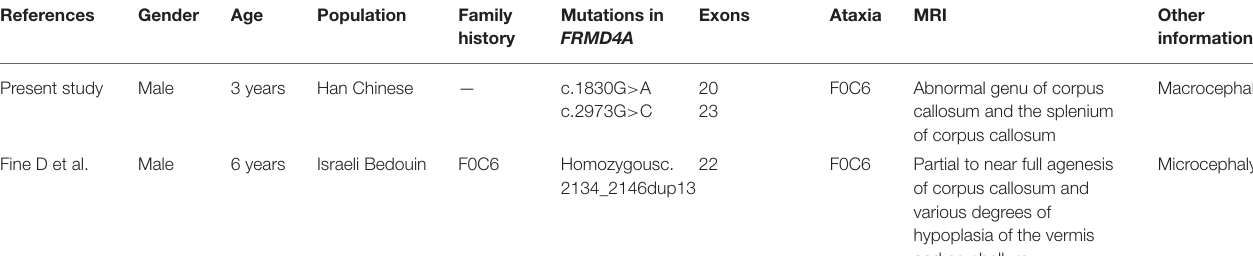
TABLE 2 | Summary of the clinical features of the present study and published case associated with FRMD4A